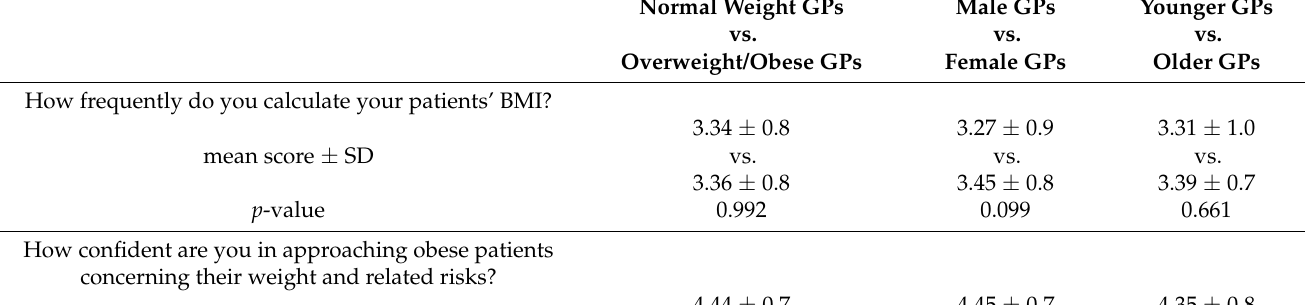
Younger GPs Male GPs vs. vs. Older Female GPs